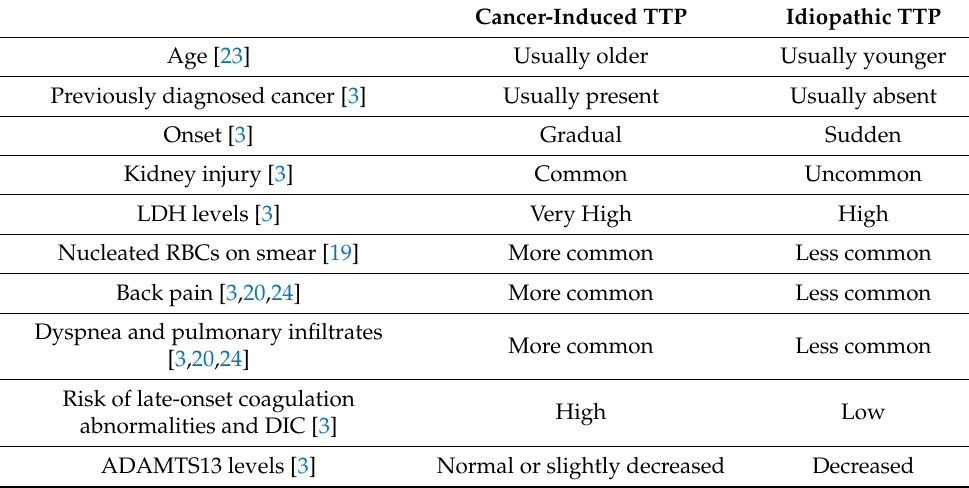
Table 2. Differences between cancer-induced and idiopathic